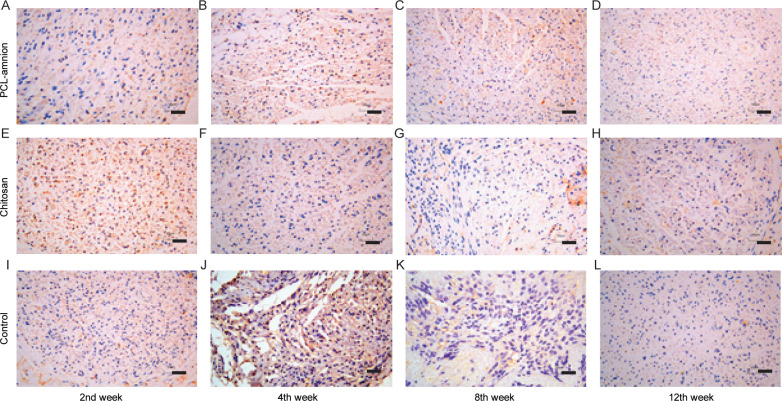
Immunohistochemical results of CCR7-positive M1 macrophages at each time point (x400).(A-D) The PCL-amnion group. (E-H) The chitosan group. (I-L) The control group. Scale bar = 50 μm.